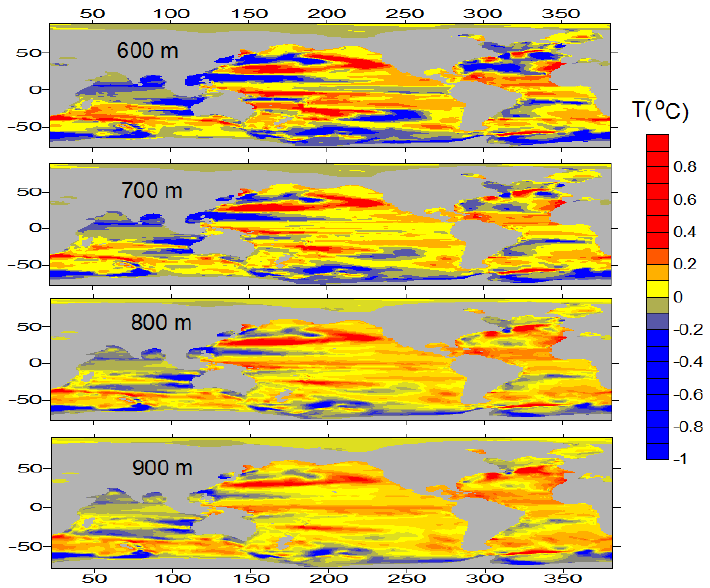
Figure 7. Perturbations in the WO temperature (°C) in the deep part of the active upper layer (levels 600, 700, 800, 900 m) from the phase of 1948–1974 to the phase of